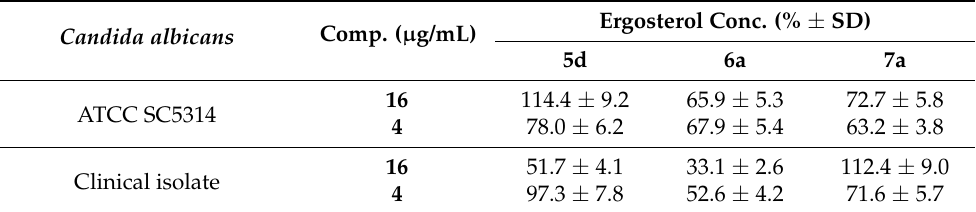
Table 6. Ergosterol quantification in the benzoxazole-treated C. albicans using HPLC. Candida